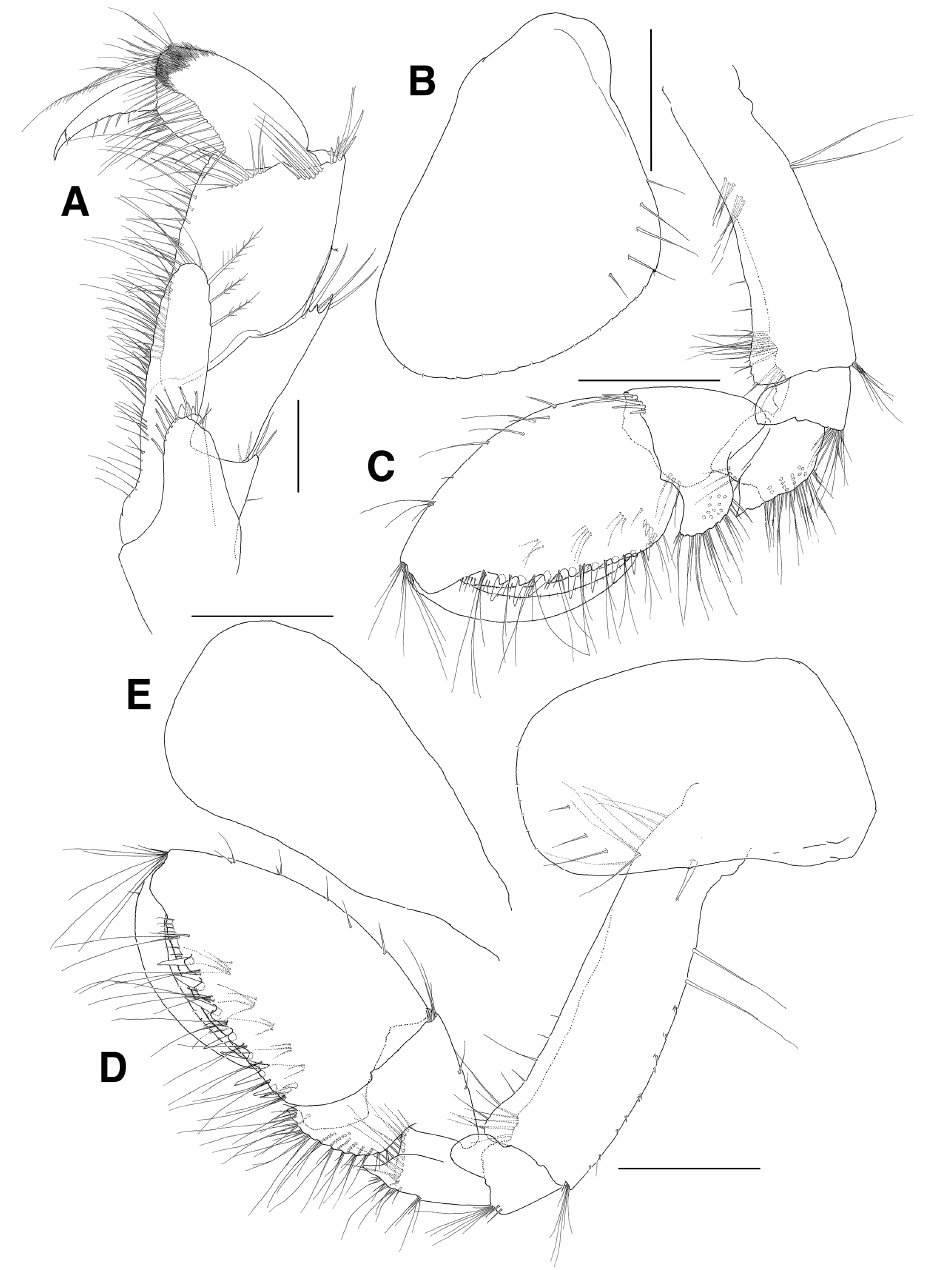
Figure 2. Eusiroides pilopalpus sp. n., holotype. A Maxilliped B Coxa 1 C Gnathopod 1 D Gnathopod 2 E Coxal gill of gnathopod 2. Scale bars 0.2 mm ( A ), 0.5 mm ( B–D